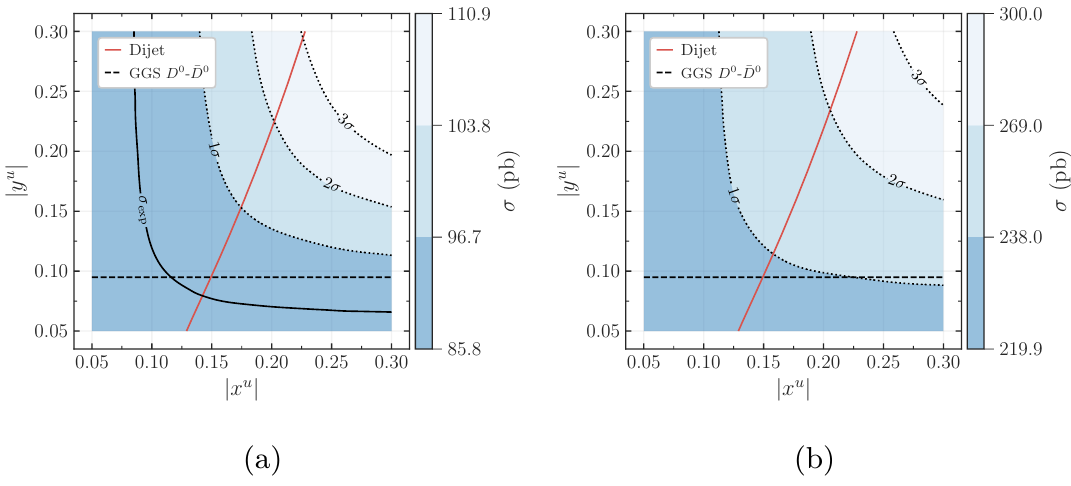
Figure 7 . Theoretical predictions of the total STP cross section (cid:27) including the contributions of the diquark D u . Results are shown for M D u = 600 GeV at (a) p s = 8 TeV and (b) p s = 13 TeV. The central value (cid:27) exp of the experimental measurement is shown (black solid line), as are the 1 (cid:27) , 2 (cid:27) and 3 (cid:27) regions (black dotted lines). Constraints from D 0 - (cid:22) D 0 mixing (black dashed line) [39] and direct searches (red solid line) (section 4) are also